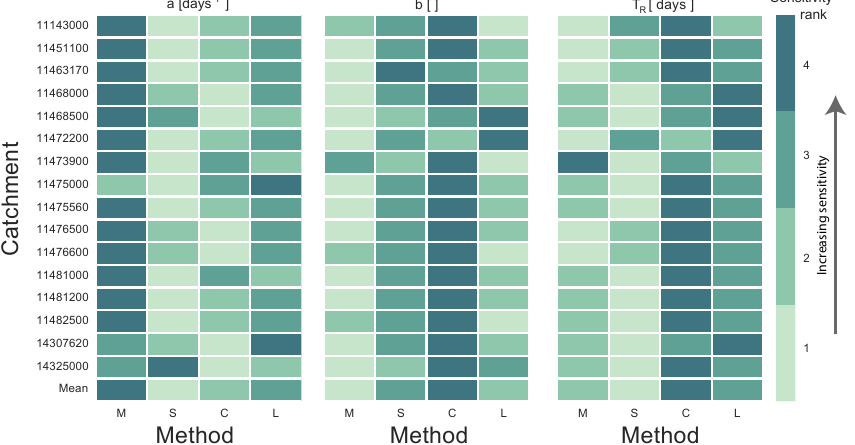
Figure 10. Results of Mann–Whitney U test sensitivity analysis. Each row represents 1 of the 16 study catchments, each subplot one of the three recession measures a , b , or T R , and each subplot column one of the four methodological choices (MSCL). Each cell is colored by a sensitivity rank. A cell shading of 4 (darkest) means that method choice had the highest number of significantly different shared and unshared distributions for that recession measure in that catchment, indicating that the particular recession measure is highly sensitive to the corresponding method